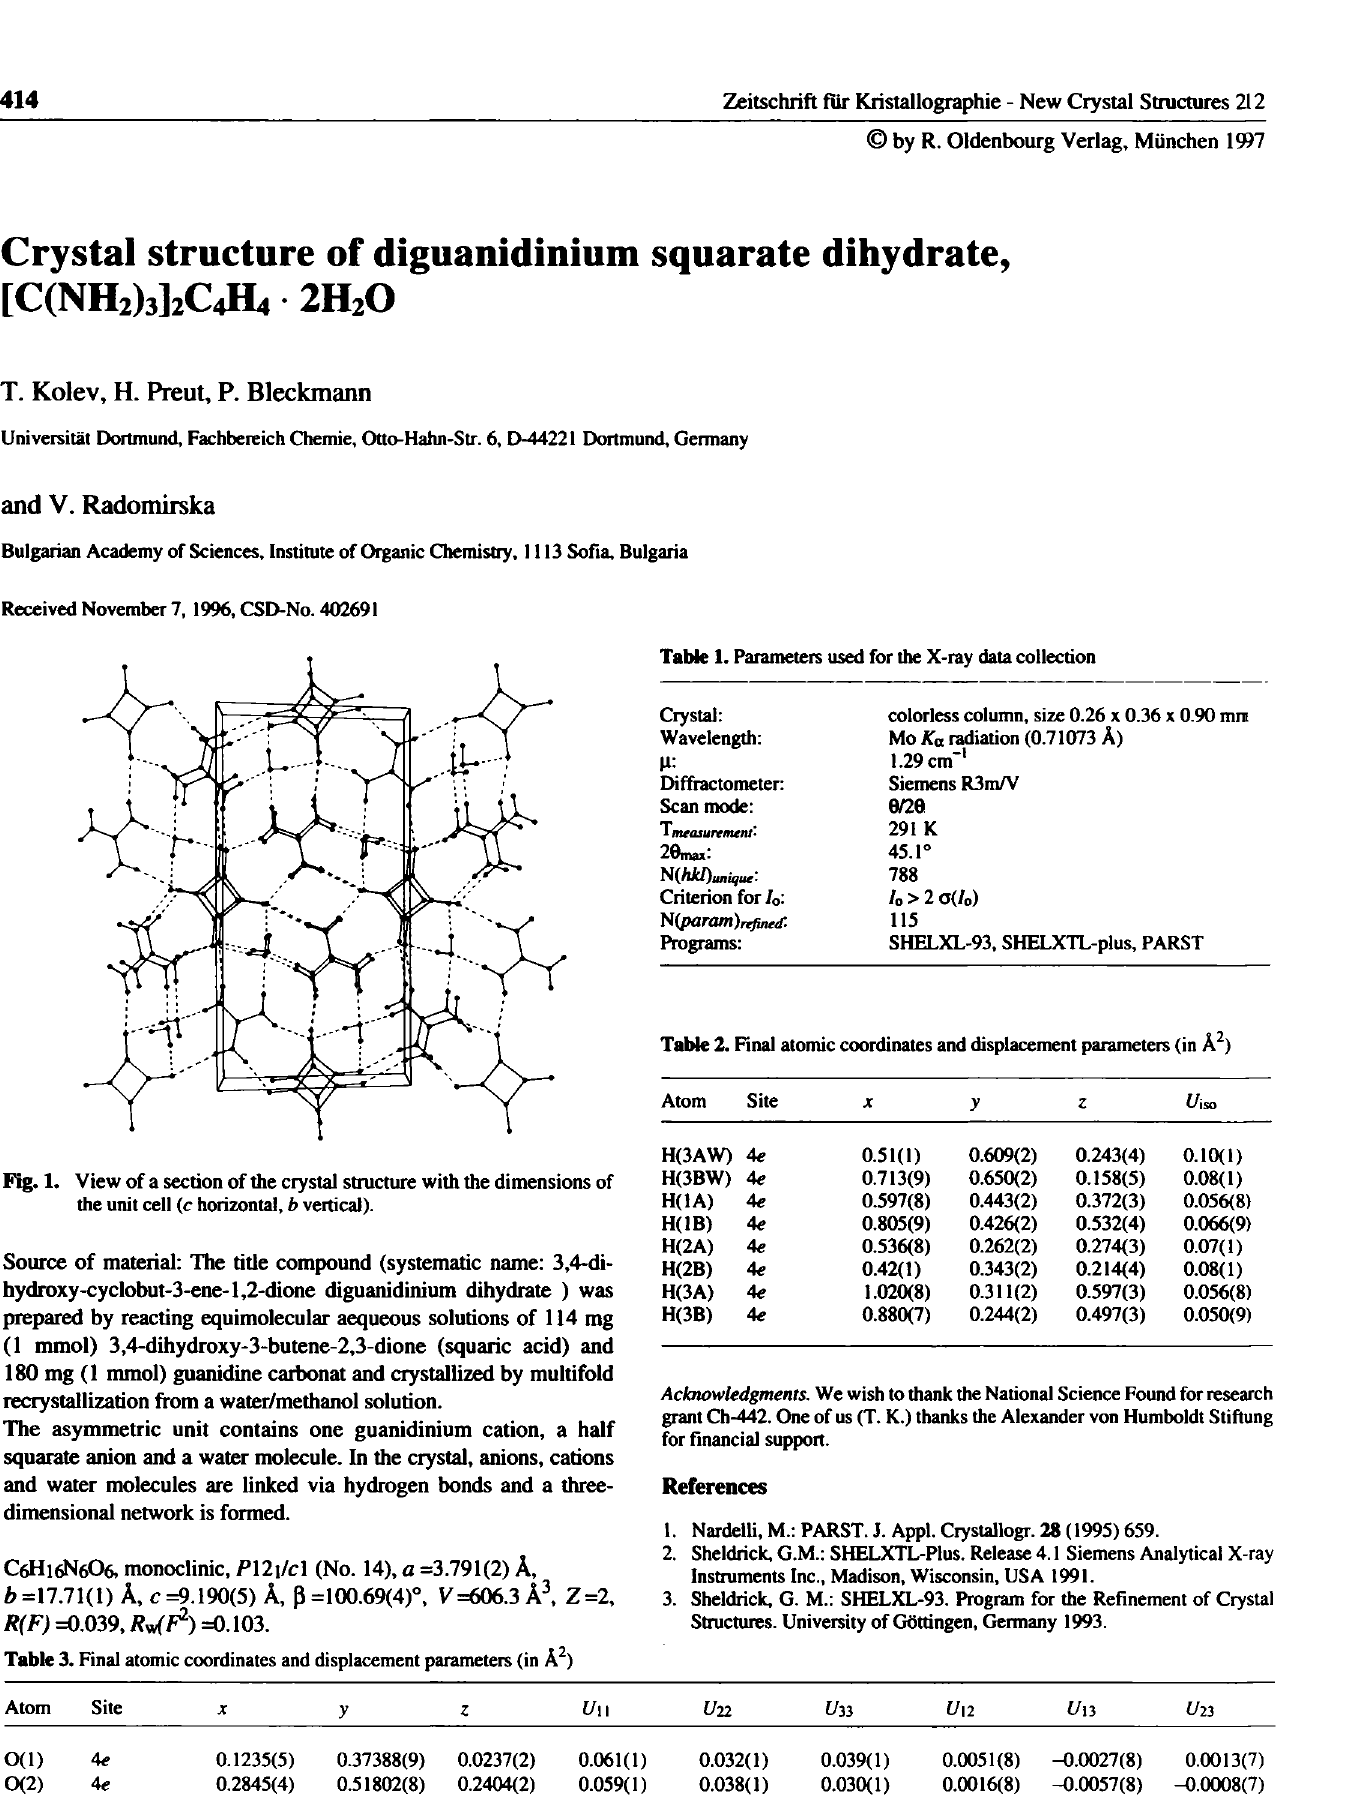
Table 3. Final atomic coordinates and displacement parameters (in À 2 )